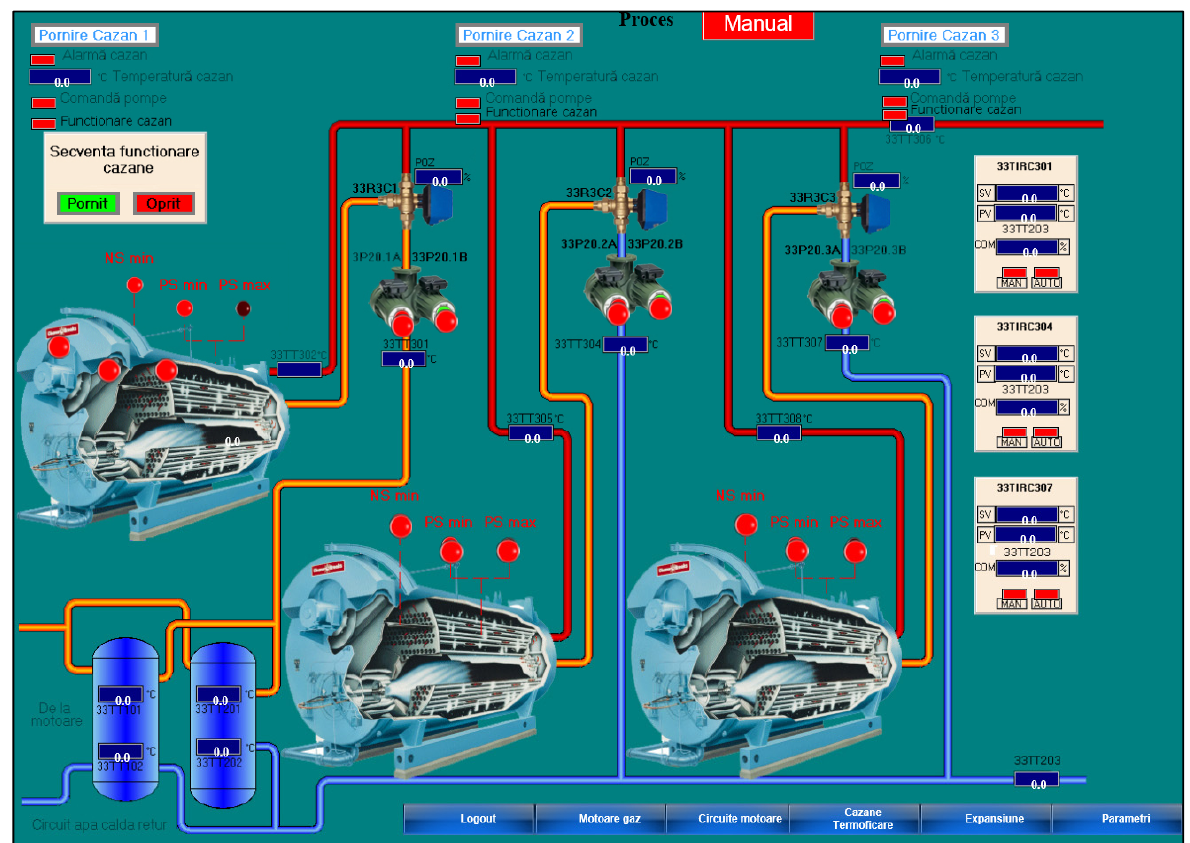
Figure 7. A detailed dashboard for the cogeneration plant.